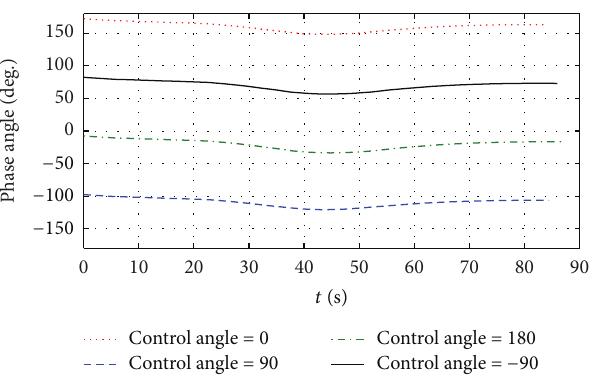
Figure 4: Curves of phase angle.